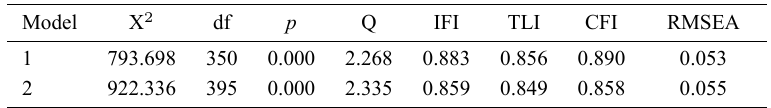
Table 5. Comparison of goodness of fit between the model applying equivalence and constraint between groups and the baseline model.